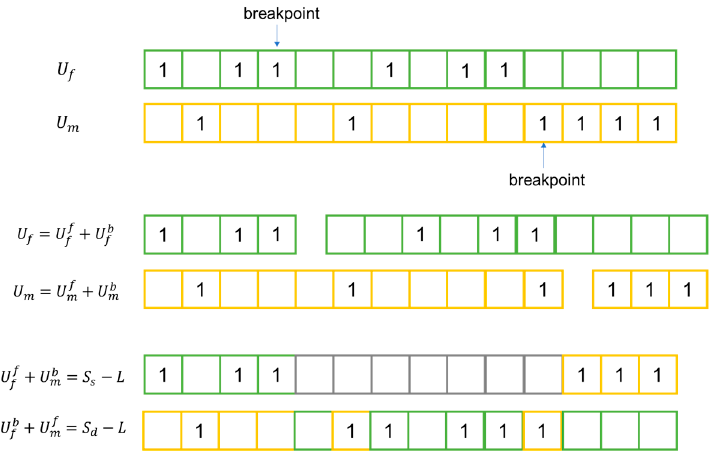
Figure 4. Illustration of the crossover operation.